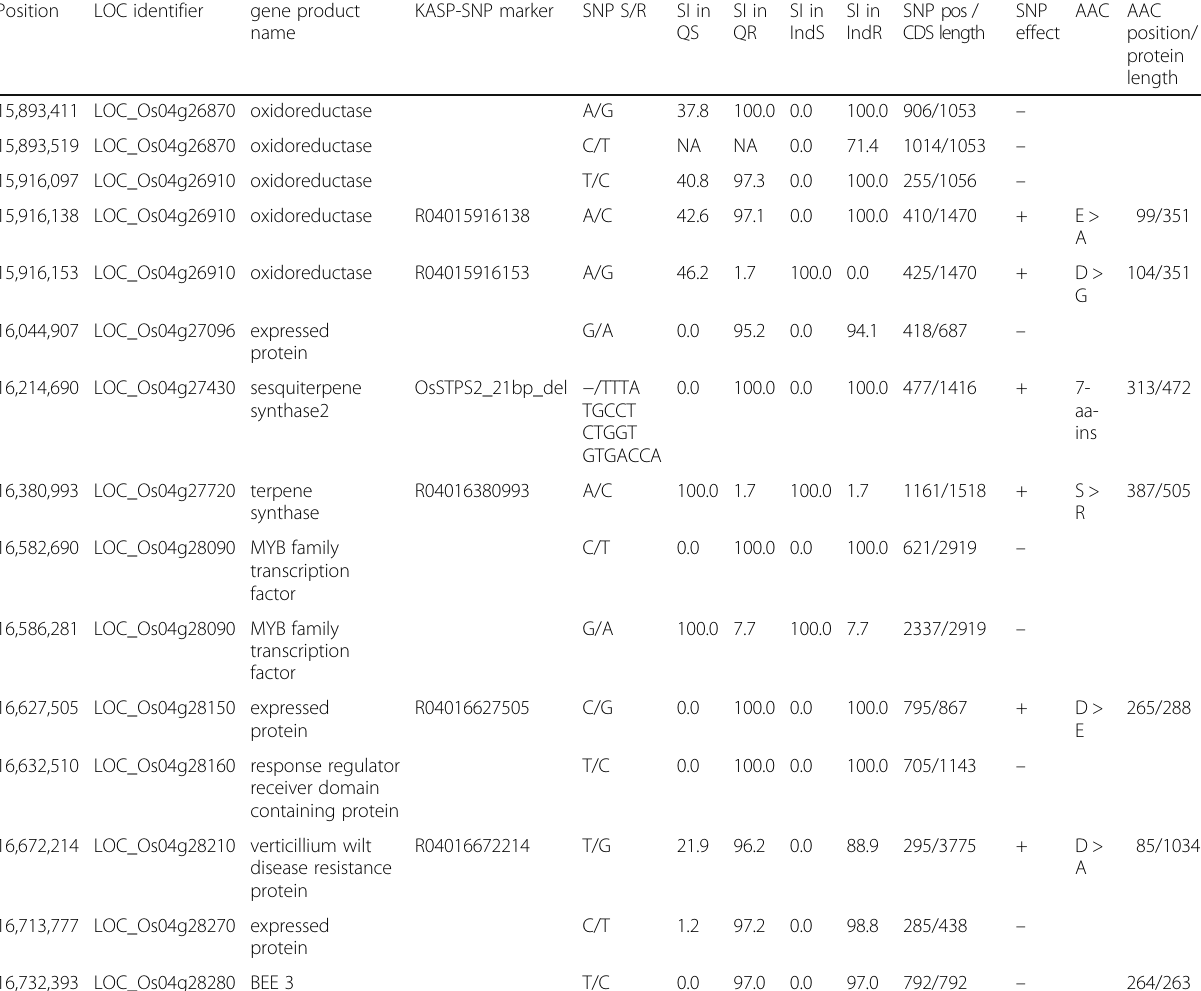
Table 2 List of SNP identified on the QBPH4.2 sliding window (15.22 – 17.22 Mb) on chromosome 4. SI = SNP index; QS = QBPHS; QR = QBPHR; IndS = BPHS; IndR = BPHR; AAC = amino acid change; ( − ) = synonymous variant; (+) = missense variant or stop codon